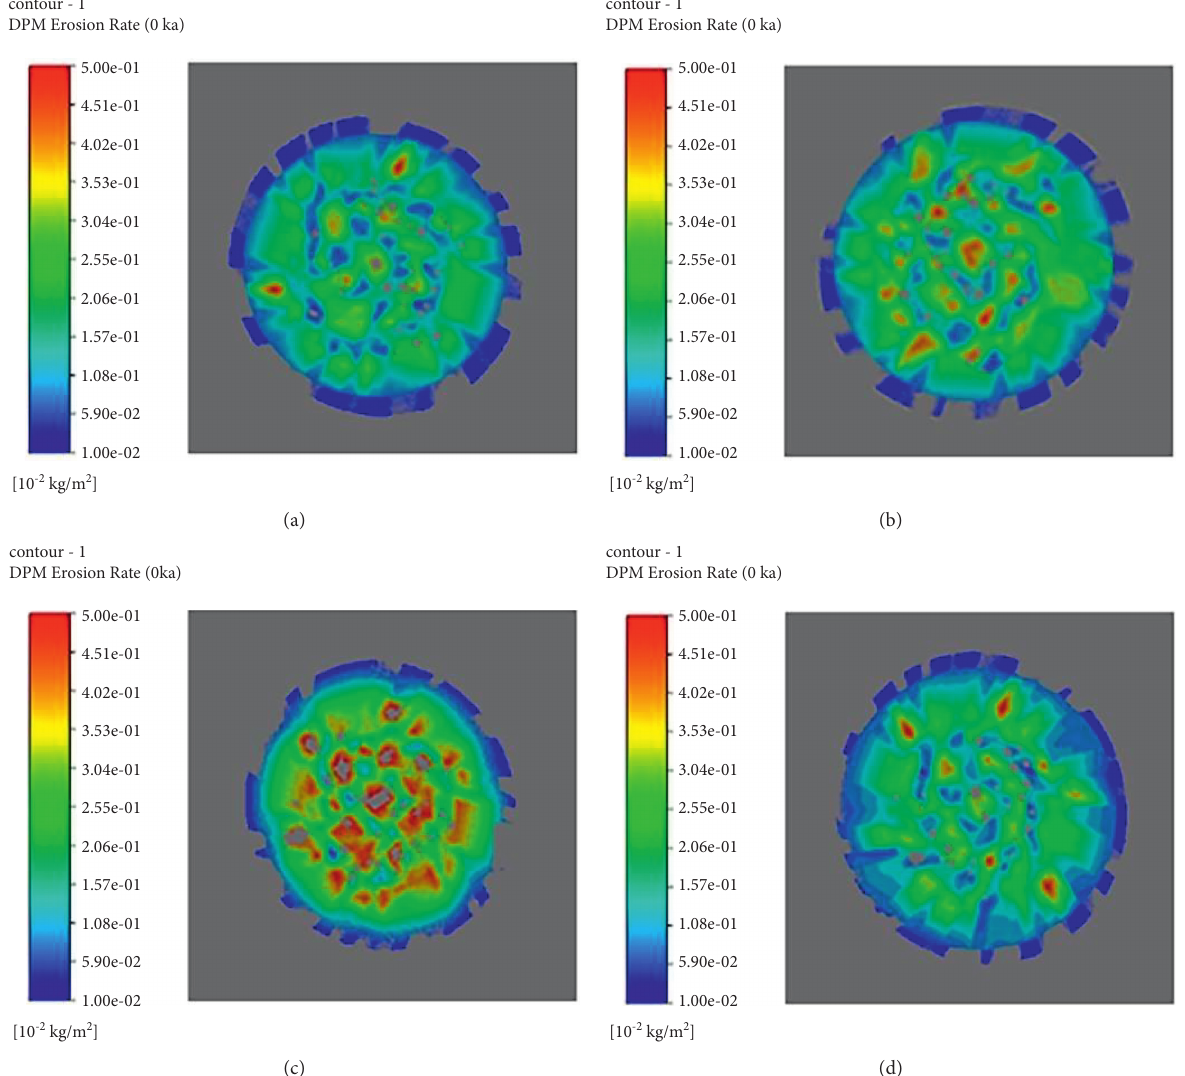
Figure 11: The erosion of the blade surface with different spraying distances. (a) The erosion of the blade surface with the spraying distance of 300mm. (b) The erosion of the blade surface with the spraying distance of 400mm. (c) The erosion of the blade surface with the spraying distance of 500mm. (d) The erosion of the blade surface with the spraying distance of